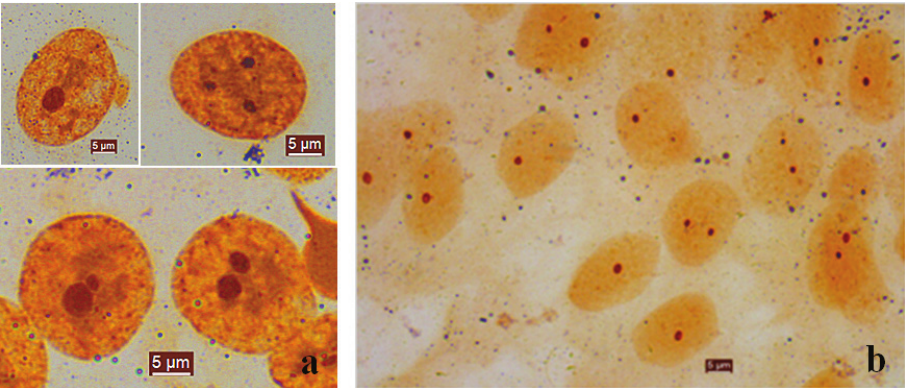
Figure 1. Ag-nucleoli of interphase. a 1, 2 or 3 normal nucleolus organizer regions (NORs) in interphase of O. minor and A. fangsiao , and the two species mainly contain 2 NORs b 1 or 2 NORs in interphase of C. chinensis , and most of them contain 1 NORs . Scale bar: 5